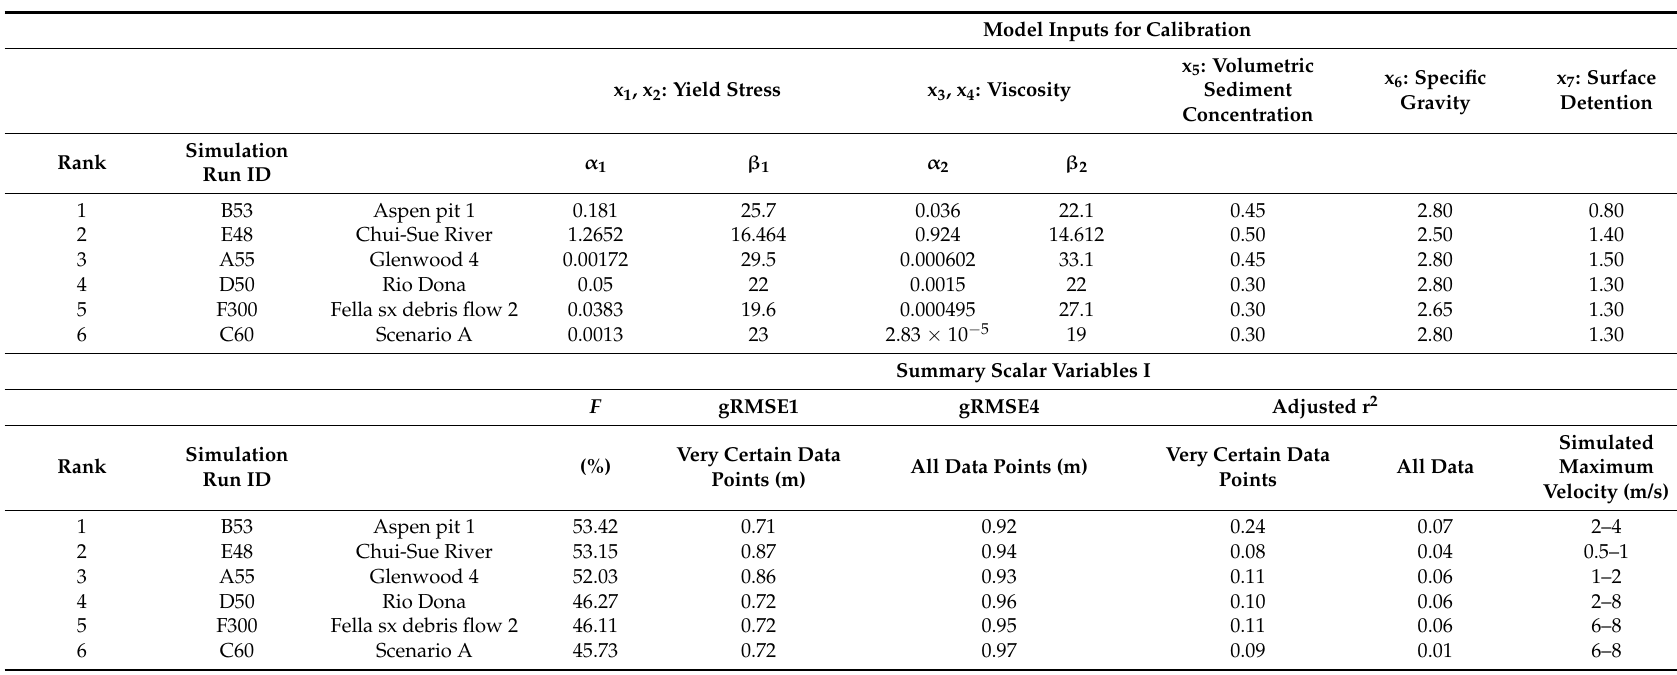
Table 6. Comparison of parameter combinations and summary scale variables for the top performing simulations runs for each of the six sets of rheologies obtained from published literature to back-calculate the 2005 debris flow in